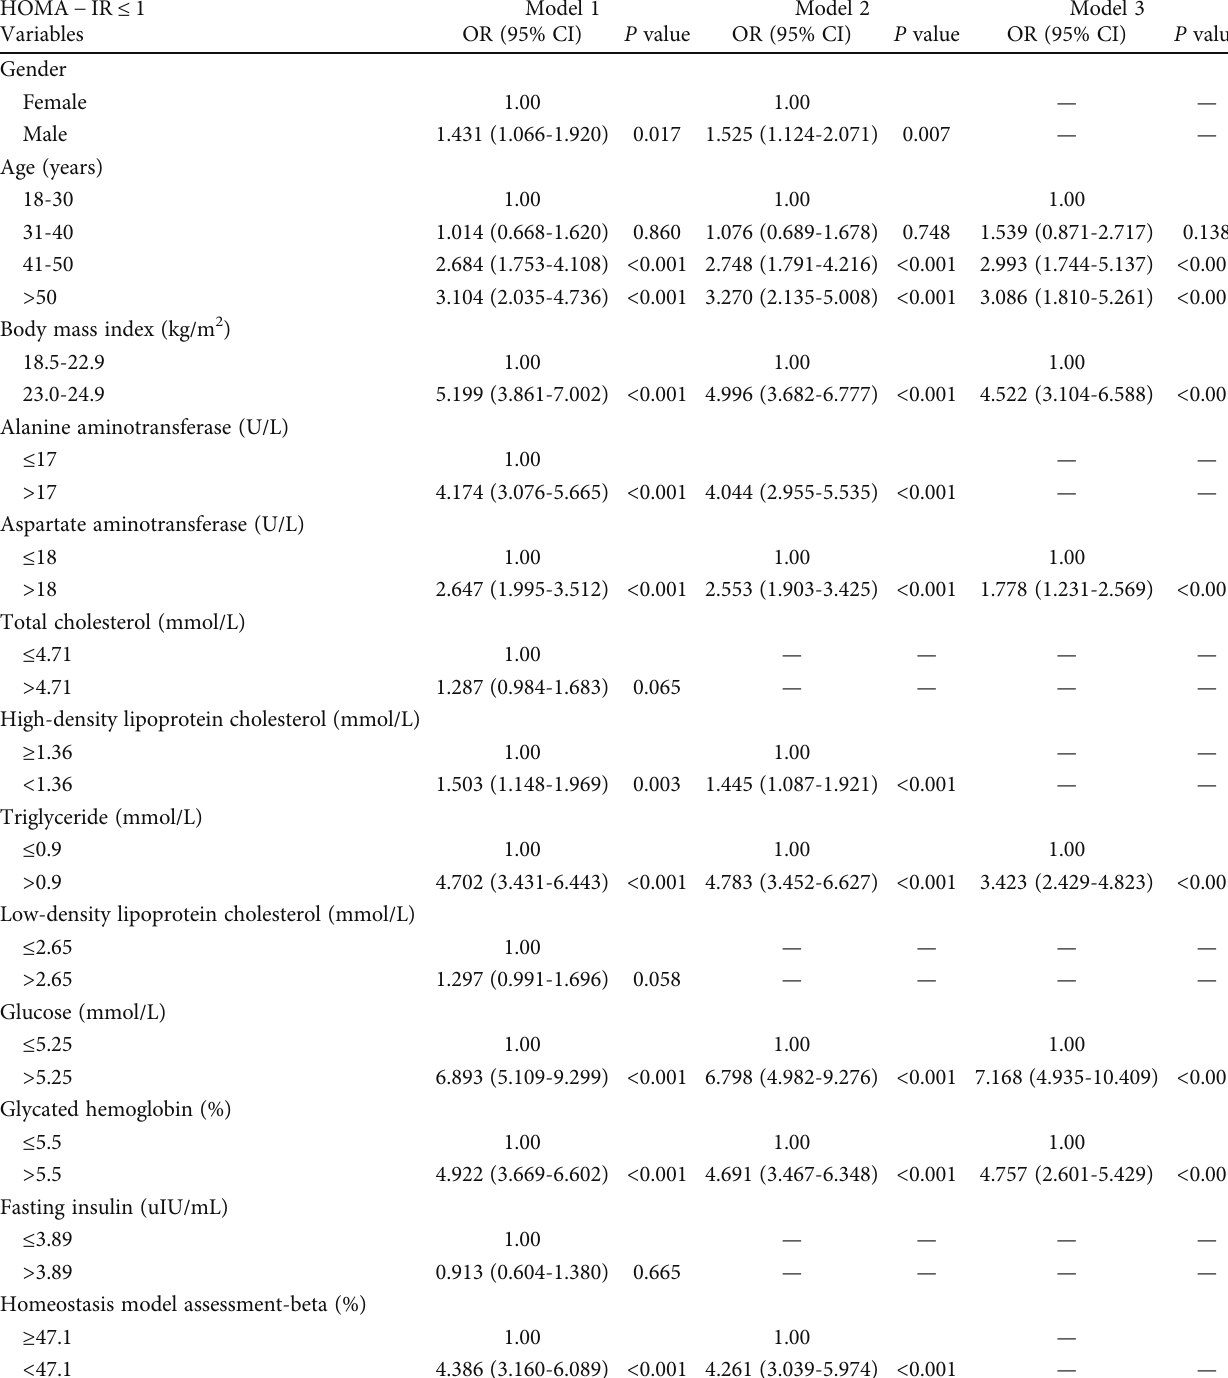
Table 3: Factors associated with the presence of nonobese NAFLD in the HOMA − IR ≤ 1